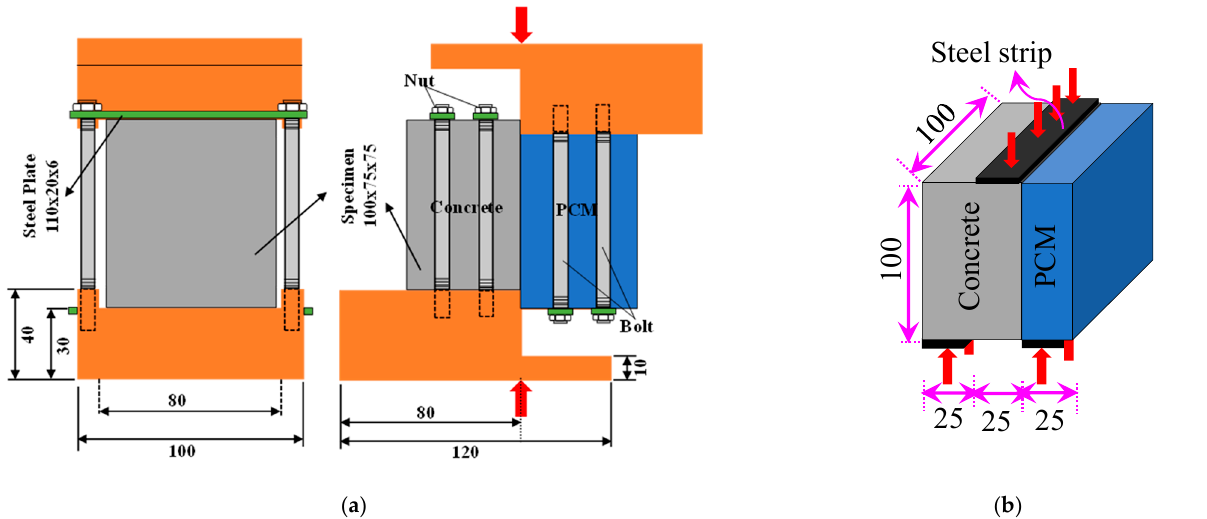
Figure 3. Schematic diagram of the tests performed with the loading condition (unit: mm). ( a ) Direct single-surface shear test. ( b ) Bi-surface shear test.